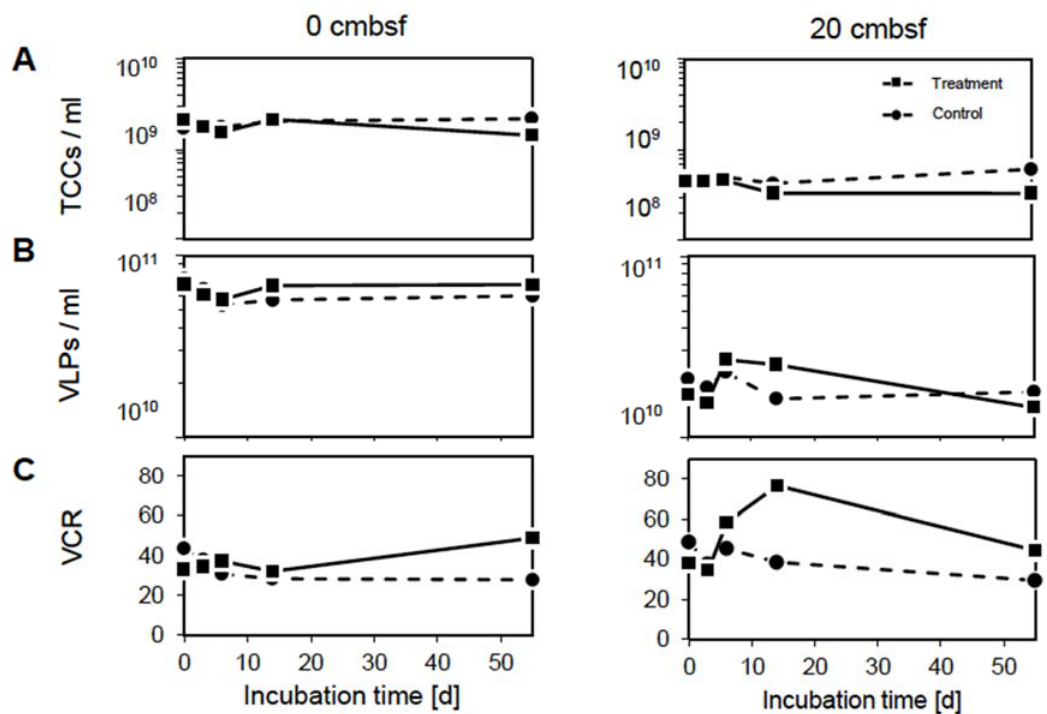
Figure 1. Changes in ( A ) prokaryotic and ( B ) virus abundances as well as ( C ) virus ‐ to ‐ cell ratio dynamics over the course of the experiment in the 0 cmbsf (left column) and 20 cmbsf incubations (right column). The mitomycin C treated incubations are displayed by the solid line and squares, the non ‐ treated controls by the dashed line and circles.